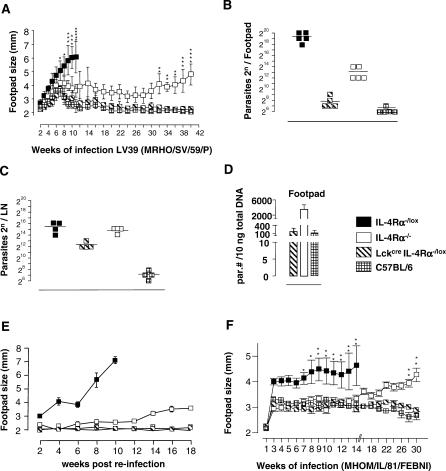
LckcreIL-4Rα−/lox Mice Control Footpad Swelling and Parasite Burden during Acute and Chronic L. major Infection(A) Lesion development. Footpad swelling was measured at weekly intervals in mice (five per group) infected with 2 × 106 stationary phase L. major LV39 (MRHO/SV/59/P) metacyclic promastigotes into the hind footpad. Asterisk indicates ulceration or necrosis/mouse. A representative of one of five experiments is shown with mean values ± SD.(B) Week six footpad parasite load. Parasite load was determined by limiting dilution of single-cell suspensions from homogenized footpads at 6 wk after infection.(C) Week six LN parasite load. Parasite load was determined by limiting dilution of single-cell suspensions from the draining LNs at 6 wk after infection.(D) L. major parasite detection using real-time PCR at 36 wk after infection. Kinetoplast DNA was quantified from footpads at week 36 after infection. One of two representative experiments is shown, with values representing mean parasite number ± SD.(E) LckcreIL-4Rα−/lox BALB/c mice are resistant to reinfection. At 6 wk after infection with L. major, mice were reinfected in the contralateral hind footpad, and footpad swelling was monitored for 18 wk. Data are representative of two independent experiments.(F) LckcreIL-4Rα−/lox BALB/c mice are resistant to L. major (MHOM/IL/81/FEBNI). Lesion development: mice (four per group) were infected with 2 × 106 stationary phase L. major (MHOM/IL/81/FEBNI) metacyclic promastigotes into the hind footpad. Asterisk indicates ulceration or necrosis per mouse. Footpad swelling was measured at weekly intervals up to week 14 and every 2 wk thereafter. A representative of one of two experiments is shown with mean values ± SD.